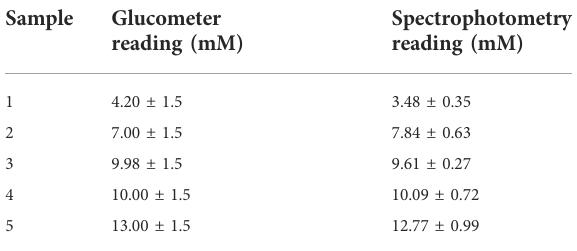
TABLE 1 Comparison of glucose concentration in human blood as determined by spectrophotometry and